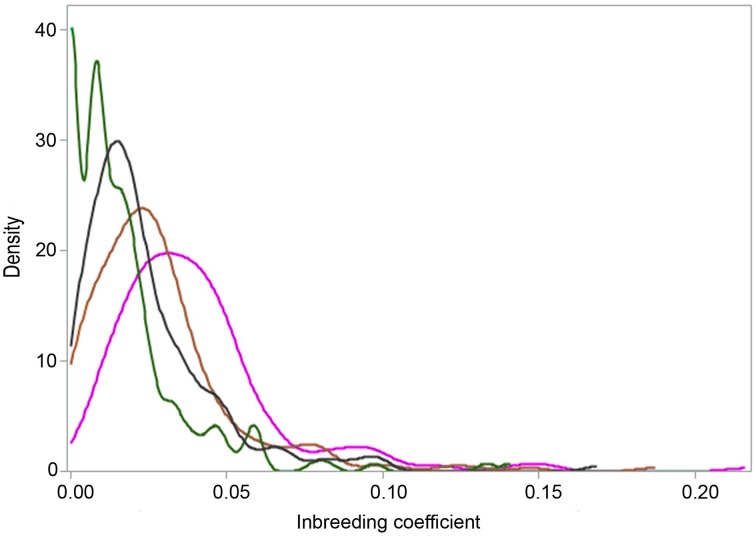
Distributions of three ROH (FROH>4 Mb in magenta; FROH>8 Mb in brown and FROH>16 Mb in green) and one pedigree (FPED in black) inbreeding coefficients for the Tyrol Grey cattle.